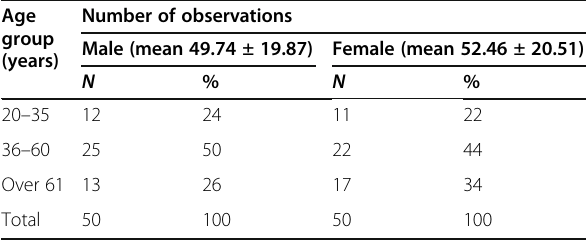
Table 1 Distribution of sample by age